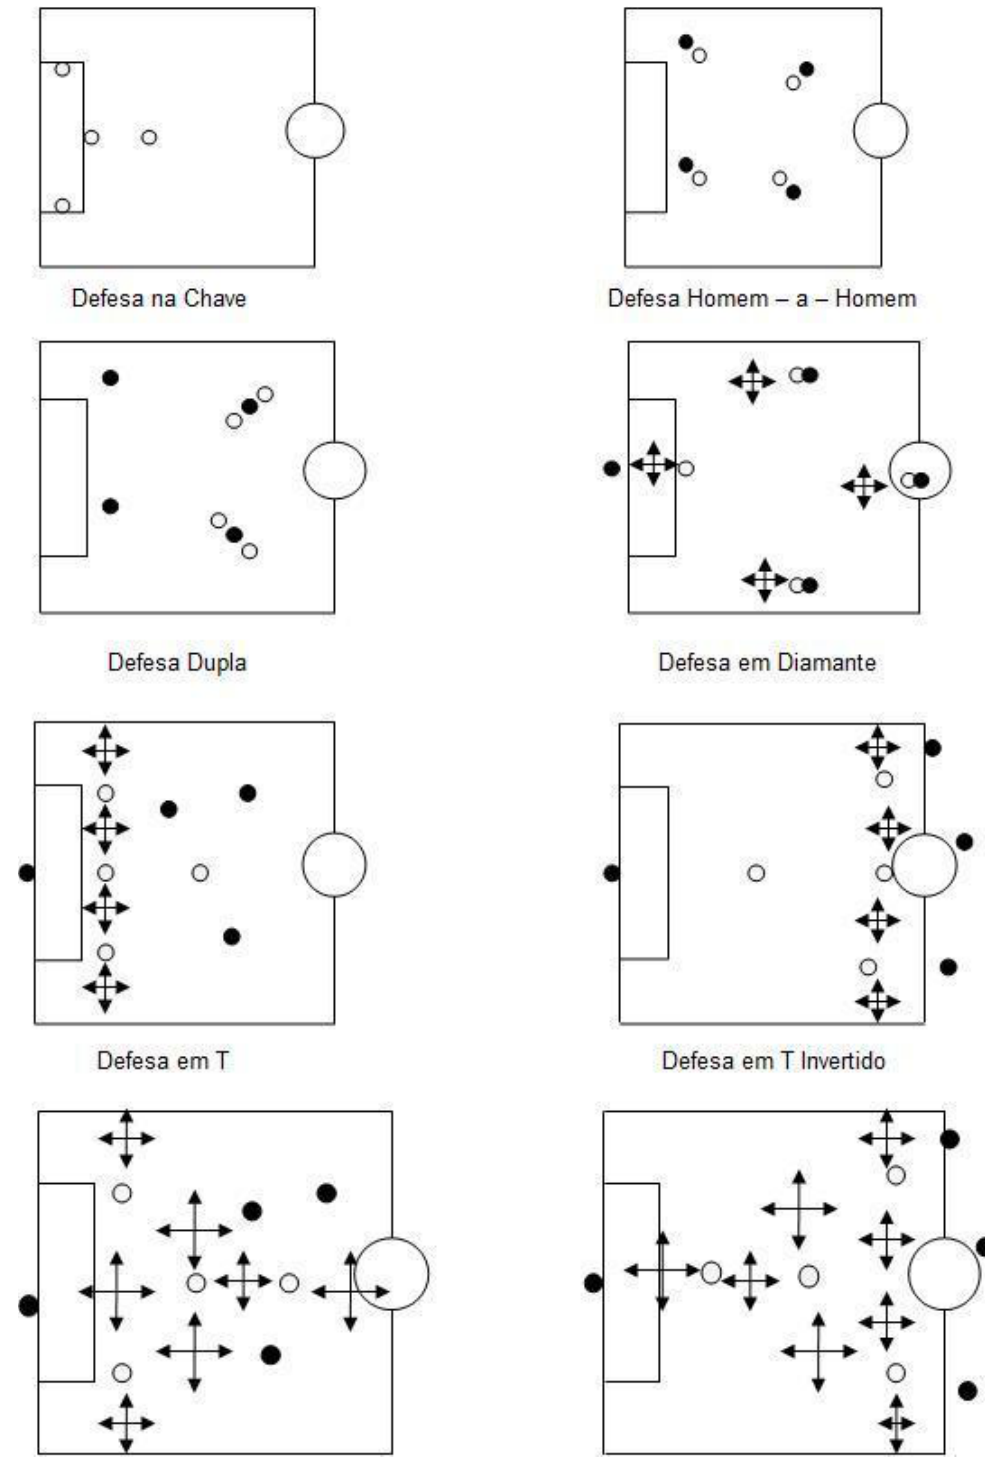
Figura 5. Os Principais Tipos de